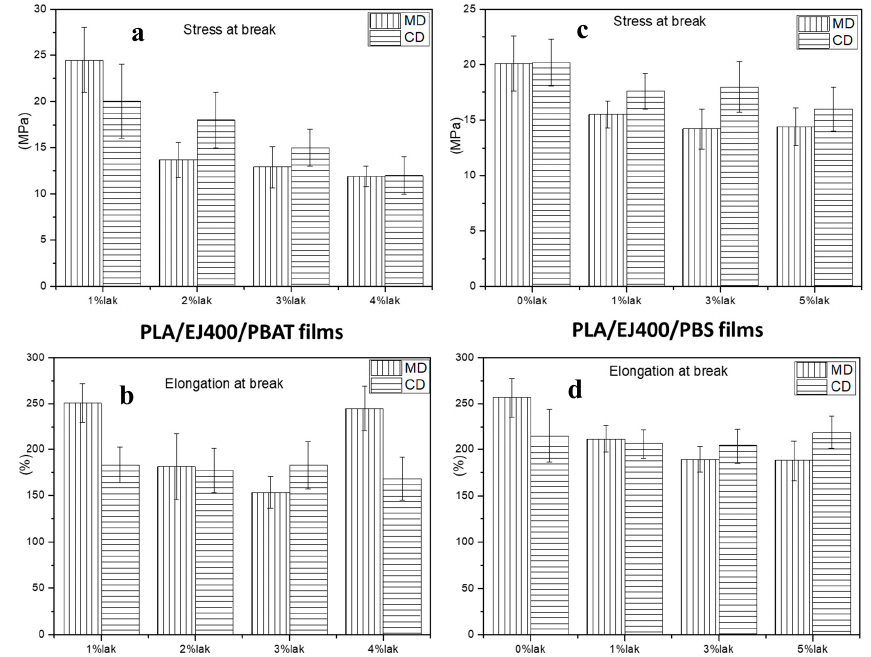
Figure 2. Tensile tests related to blown extruded films: ( a ) Stress at break of PLA/EJ400/PBAT films; ( b ) Elongation at break of PLA/EJ400/PBAT films; ( c ) stress at break of PLA/EJ400/PBS films; ( d ) Elongation at break of PLA/EJ400/PBS films